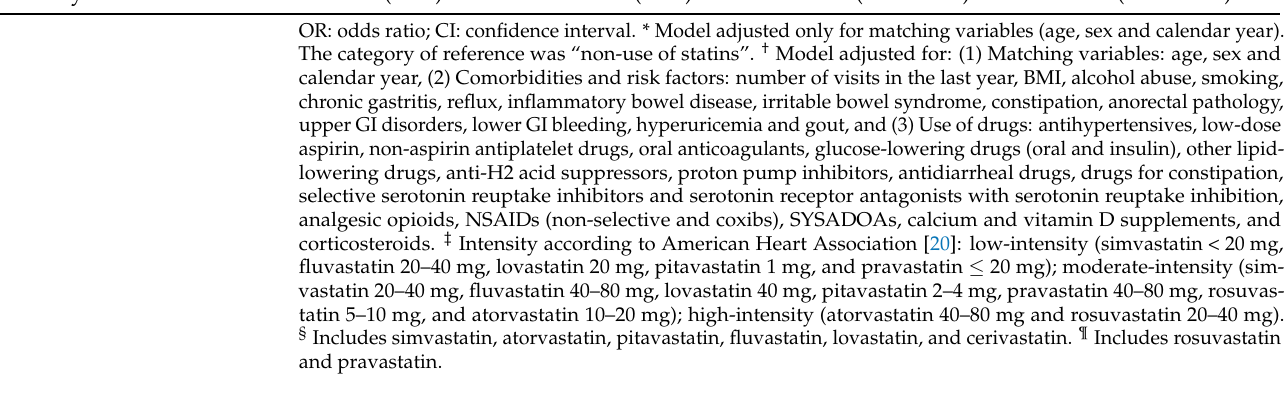
Table 5. Interactions between current use of statins and current use of cardiovascular drugs or nonsteroidal anti-inflammatory drugs (NSAIDs), and risk of colorectal